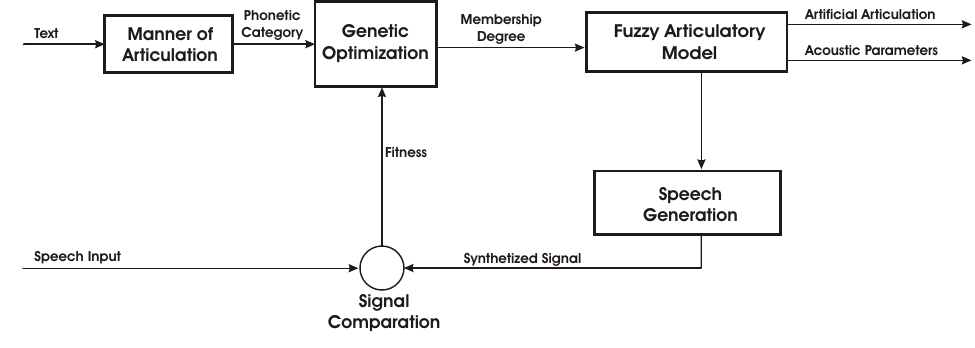
Figure 6. Block diagram of the optimization algorithm.